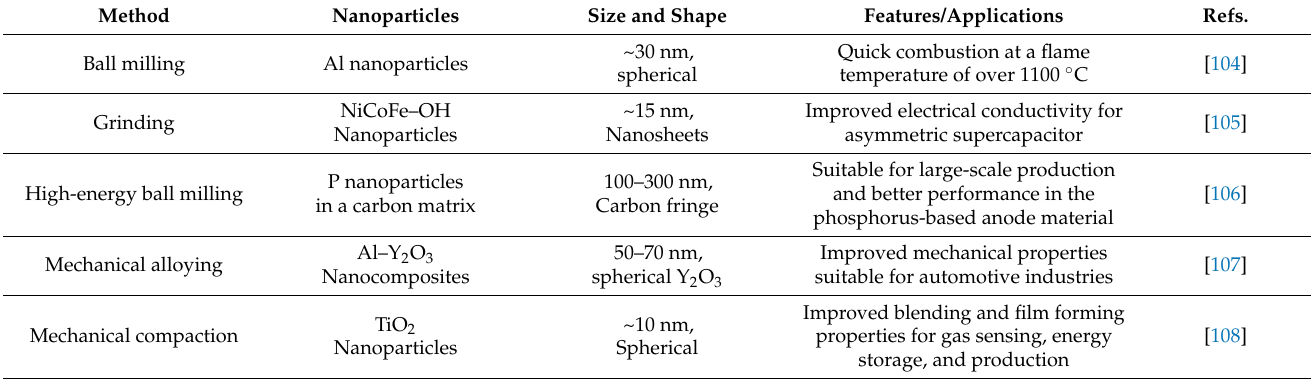
Table 1. Mechanical methods used to fabricate different nanoparticle and nanostructure